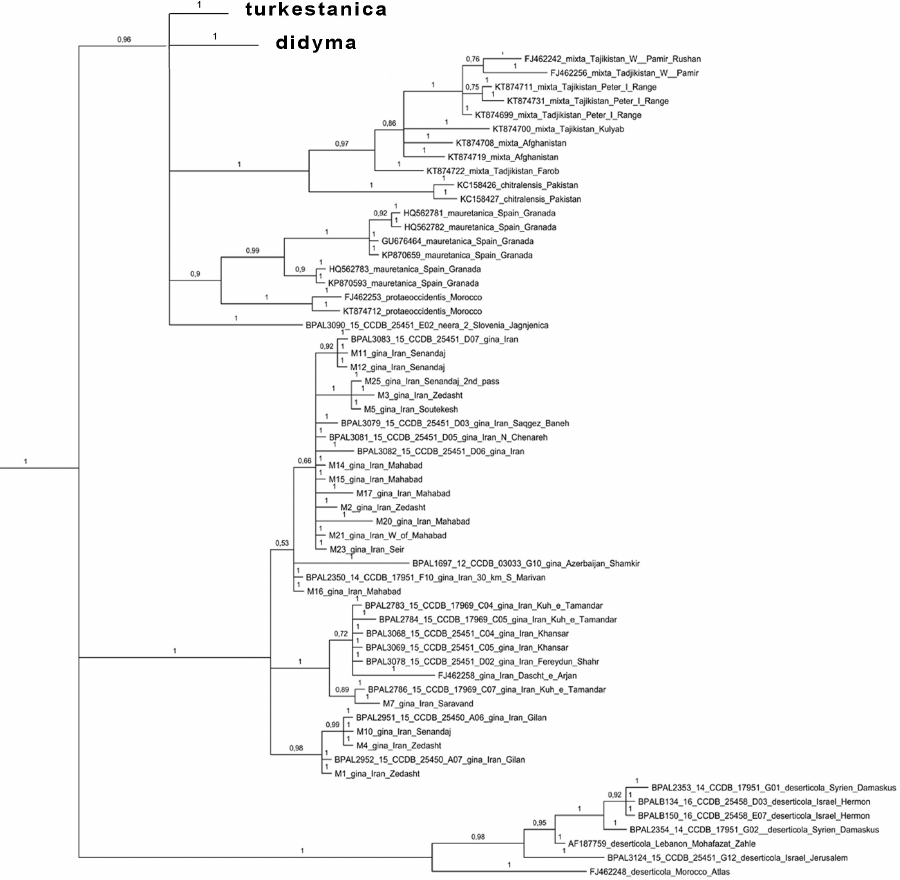
Figure 6. Fragment of the Bayesian tree of Melitaea didyma complex (haplogroups mixta , chitralensis , mauretanica , protaeoccidentis , neera2 , gina and deserticola ) based on analysis of the COI gene. Numbers at nodes indicate Bayesian posterior